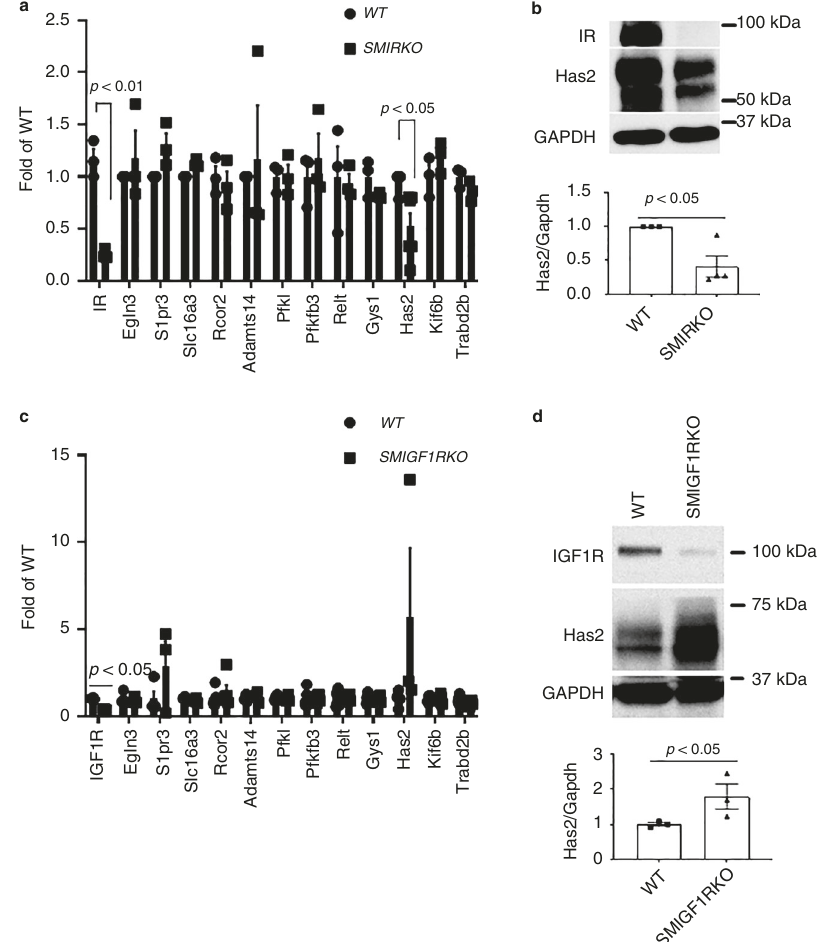
Fig. 6 Insulin targets in VSMCs. a The expression of insulin-targeted genes in aorta media of WT and SMIRKO mice. RNA was extracted from aorta media of WT and SMIRKO mice and the expression levels of genes were determined by qPCR ( WT Has2, n = 5; SMIRKO Has2, n = 6; n = 3 for each of the remaining groups). b The expression of Has2 protein in aorta media of WT and SMIRKO mice ( WT , n = 3; SMIRKO , n = 4). c The expression of insulin- targeted genes in aorta media of WT and SMIGF1RKO mice. RNA was extracted from aorta media of WT and SMIGF1RKO mice, and the expression levels of genes were determined by qPCR ( n = 3 per group). d The expression of Has2 protein in aorta media of WT and SMIGF1RKO mice ( n = 3 per group). The data are mean ± SEM. Two-tailed t test. Source data are provided as a Source Data fi